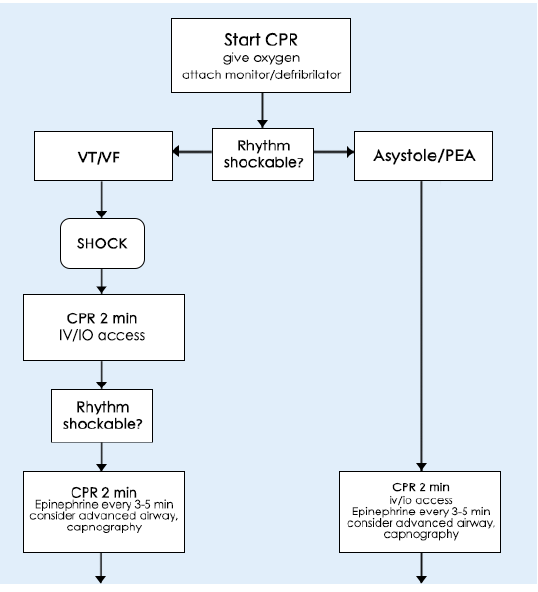
Fig. 1. A section of an ACLS diagram, without supplementary